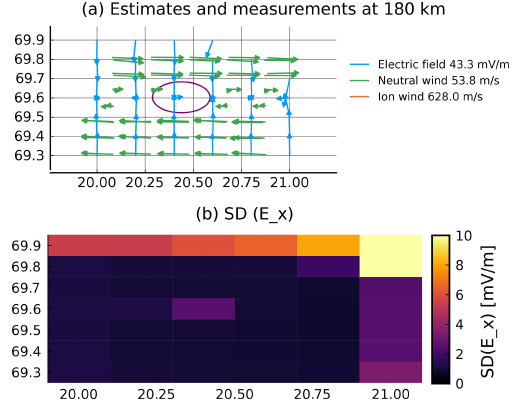
Figure 12. Estimates of electric field with measurement gap. Three central measurement beams have been removed. Panel (a) shows the remaining measurements and new estimates of electric field be- tween 180 and 190km. At other altitudes, the estimates show simi- lar changes compared to Fig. 11. Panel (b) shows the corresponding uncertainties in “northward” electric field. At other altitudes, these show similar changes compared to Fig.